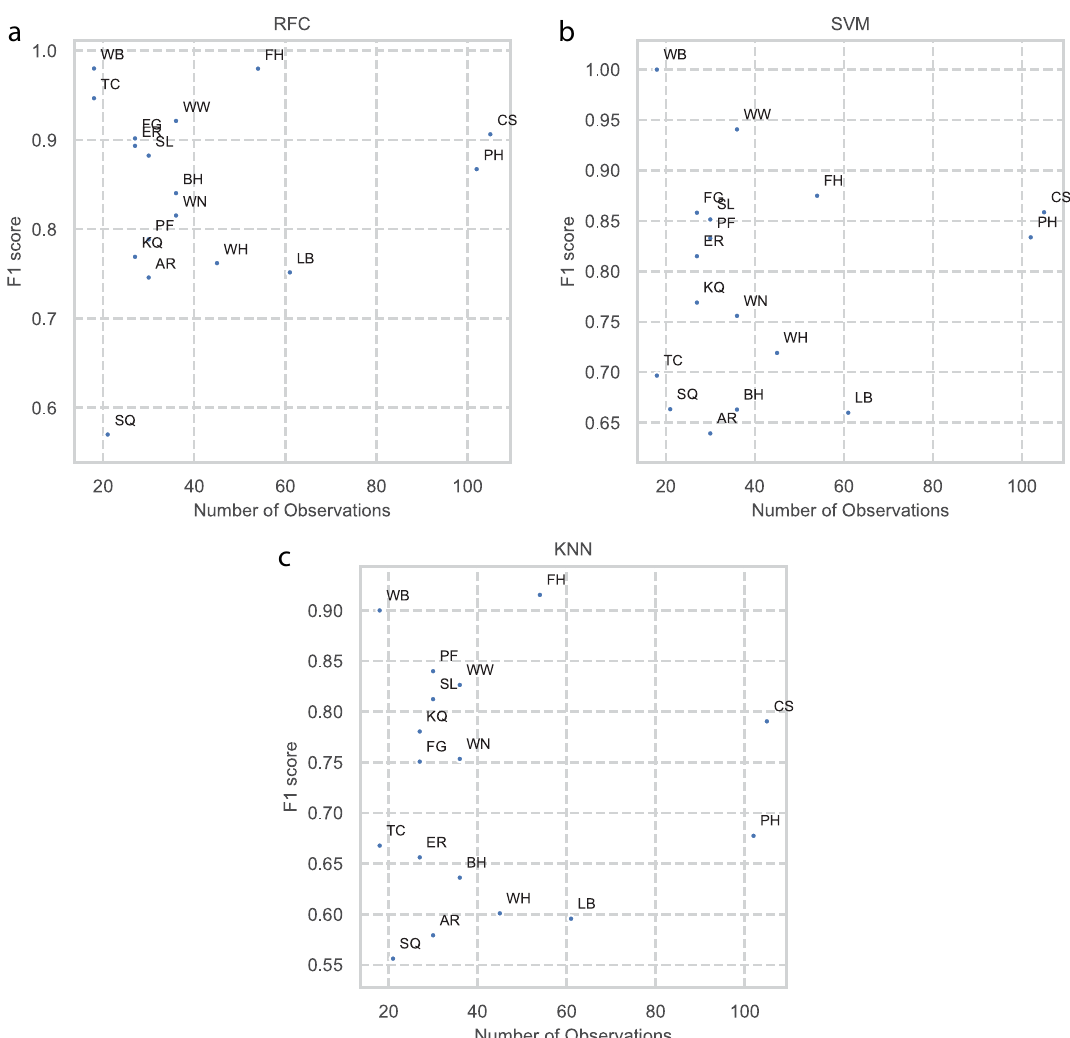
Figure 10. Graphical analysis of effect of class imbalance of class F1 scores. Scatterplots showing relationship between class F1 score and number of observations in the class for Random Forest Classifier ( a ), Support Vector Machine ( b ) and K nearest neighbour ( c